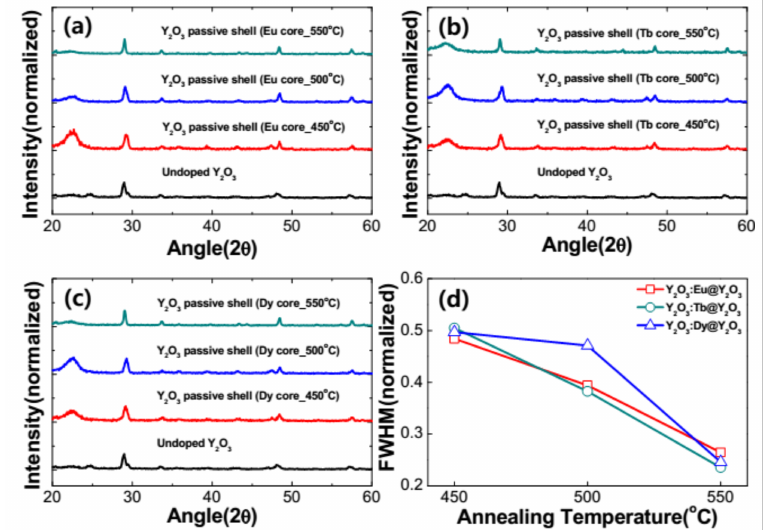
Figure 6. XRD patterns of the RE-doped Y 2 O 3 core coated with Y 2 O 3 passive shell via different annealing temperatures at 450, 500, 550 ◦ C. ( a ) An amount of 0.05 mM of Eu 3+ -doped Y 2 O 3 core with a Y 2 O 3 passive shell, ( b ) 0.05 mM of Tb 3+ -doped Y 2 O 3 core with a Y 2 O 3 passive shell and ( c ) 0.05 mM of Dy 3+ -doped Y 2 O 3 core with a Y 2 O 3 passive shell, and ( d ) FWHM of RE (Eu, Tb and Dy)-doped Y 2 O 3 core with a Y 2 O 3 passive shell at 450, 500, 550 ◦